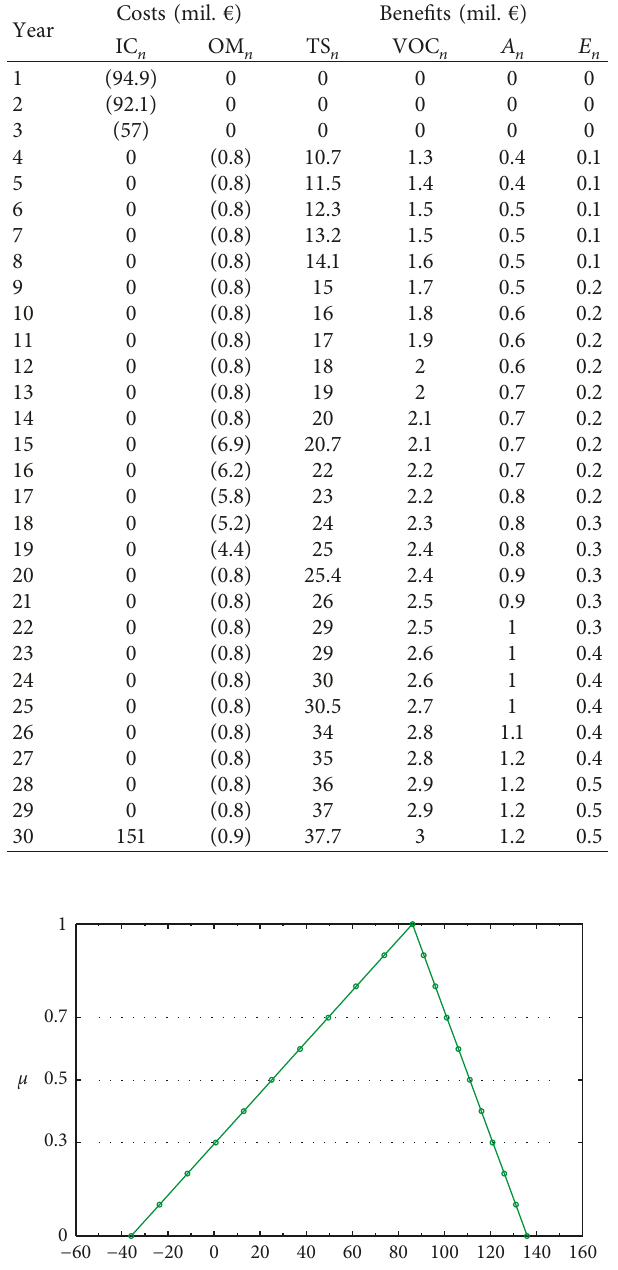
Table 1: Baseline data for motorway construction [33]. Costs (mil. € ) Year